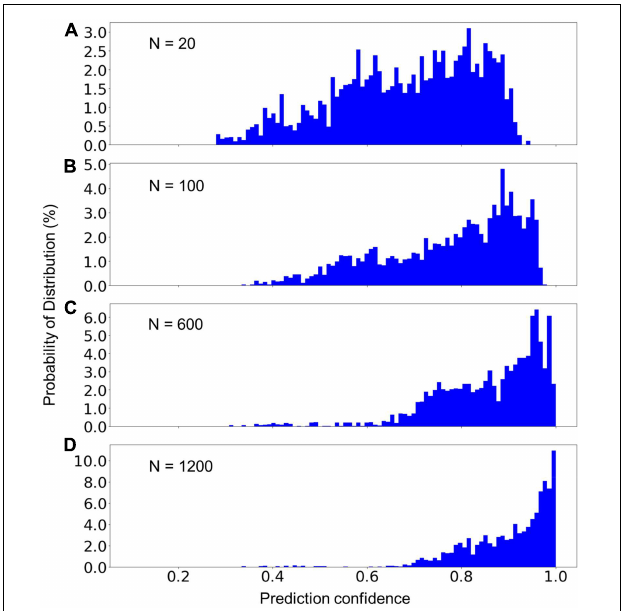
FIGURE 4 | The percent distribution of the prediction confidence of the random forest model built from different sizes of the training datasets. From (A–D) , the training datasets consisted of 20, 100, 600, and 1,200 scans from each of the sequence types 1–7 listed in Table 2 . The data are collected from 20 separate computations.